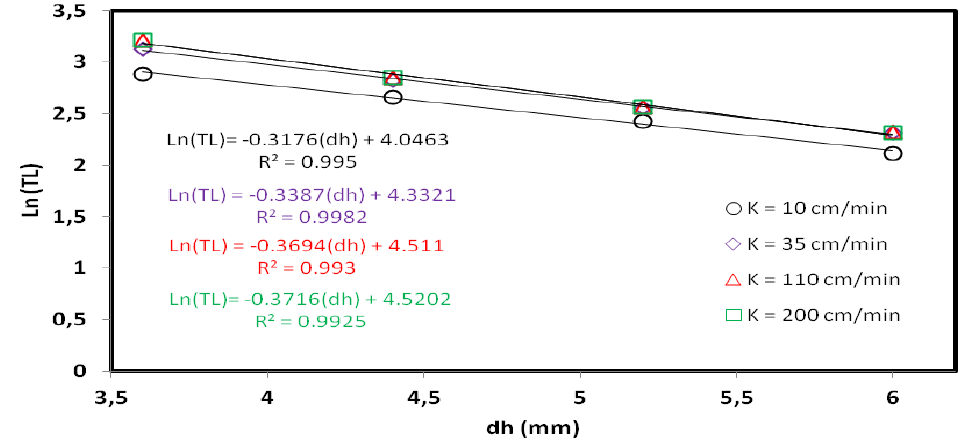
Figure 9. Change of the logarithmic toe length with the head difference for different head change magnitude.